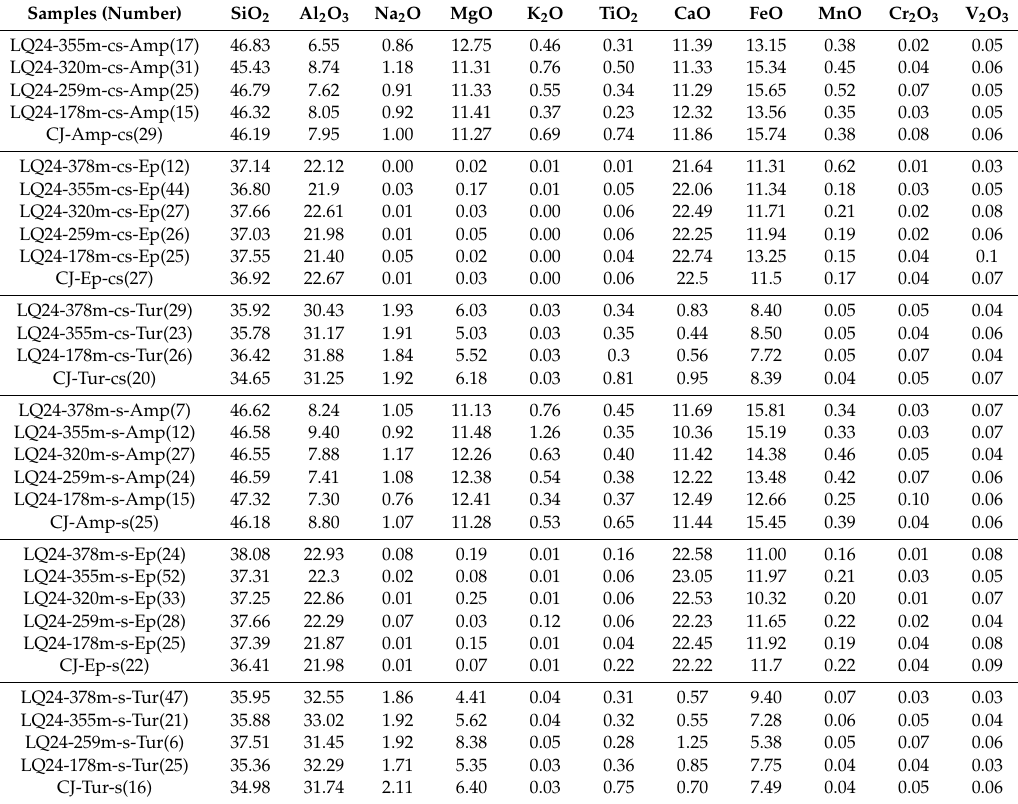
Table 1. Average element compositions (%) of amphibole, epidote, tourmaline of Core LQ24 and modern Changjiang River. s = Very fine sand fraction (63–125 µ m), cs = Coarse silt fraction (32–63 µ m). CJ = Changjiang